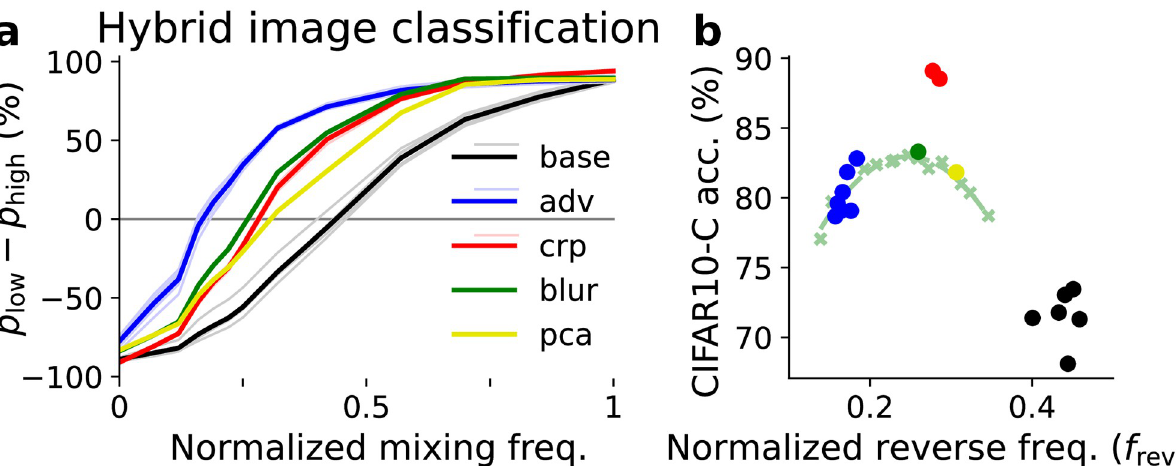
Fig 5. Hybrid CIFAR10 image classification performance of robust models. (a) Difference between probability of choosing the low frequency label vs the high frequency label of hybrid images. As in Fig 4, light thin lines represent each individual model and thick lines are the average within each group. (b) Scatter plot of model accuracy on CIFAR10-C dataset versus reversal frequency f rev in hybrid image classification. The dashed green line is the performance of a series of ‘blur’ models, using different degree of low-pass filtering. The left end corresponds to σ = 3 pixels and the right end corresponds to σ = 1 pixel, while the green dot is the model with σ = 1.5 pixel listed in Table B in S1 Appendix.